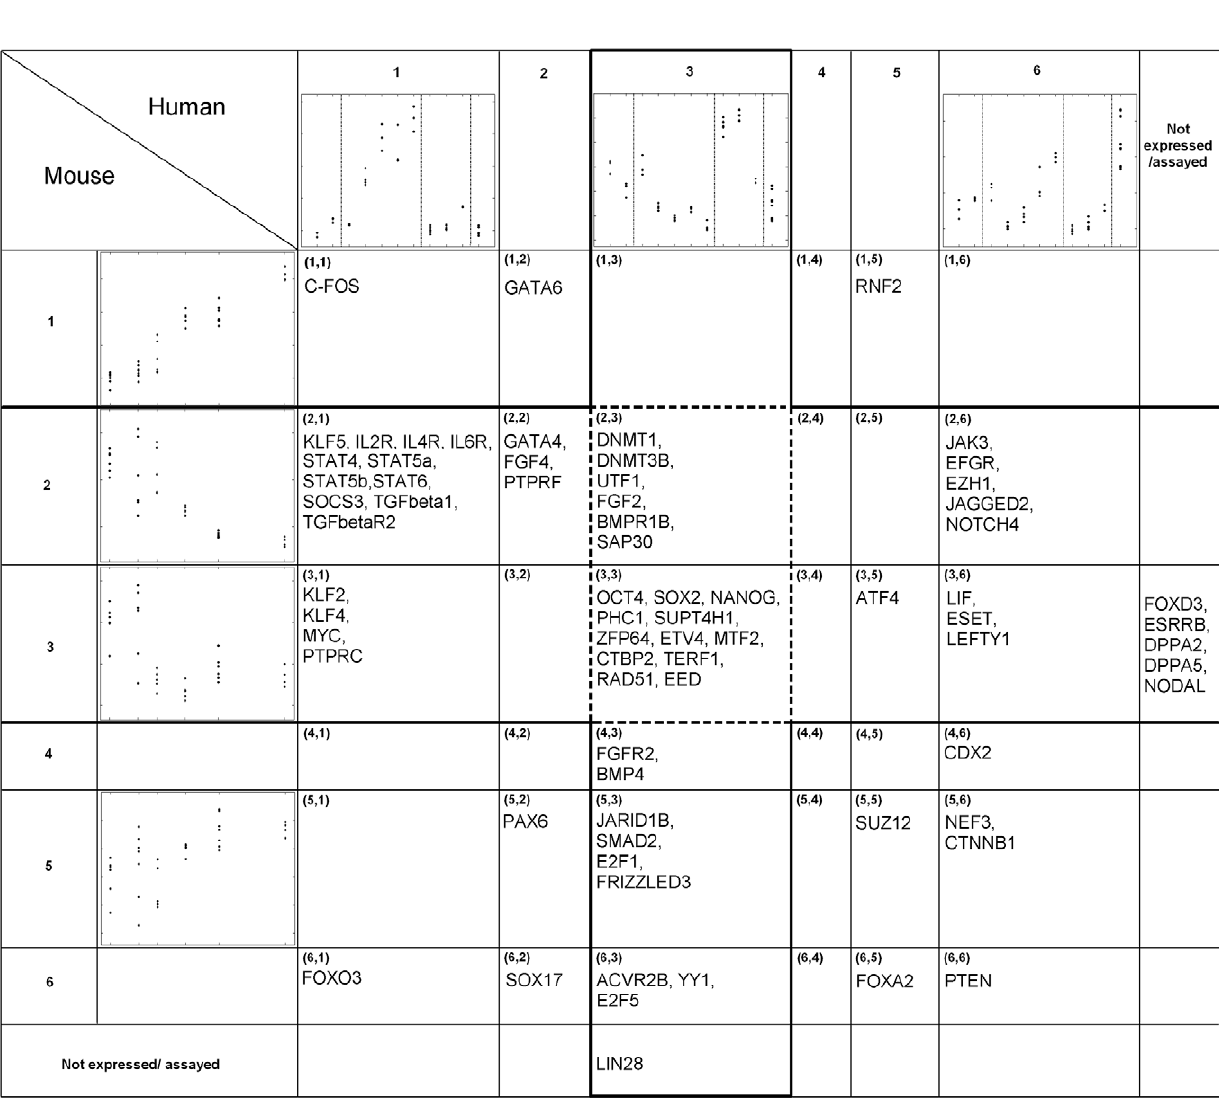
Figure 2. SCSC clusters of mES and hES cell differentiation data. Representative transcription regulators are listed in each cluster. Thick lines enclose clusters with upregulation in either mouse or human ES cells. Dotted lines enclose the conserved clusters with upregulation in ES cells of both species. Detailed expression patterns of every cluster and sample information are given in Figure S2.